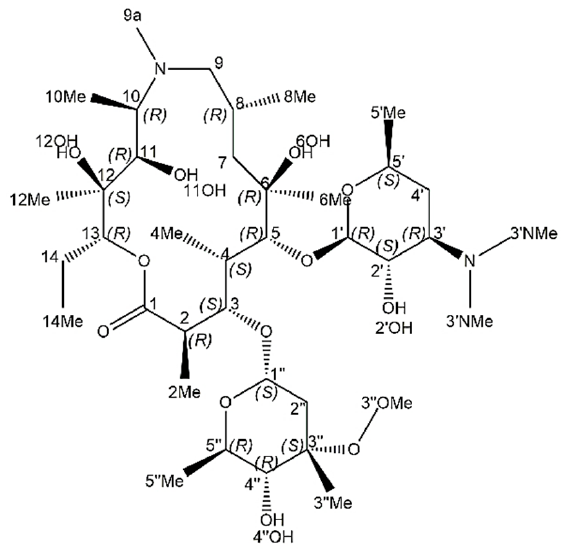
Figure 7. Absolute configuration for azithromycin.